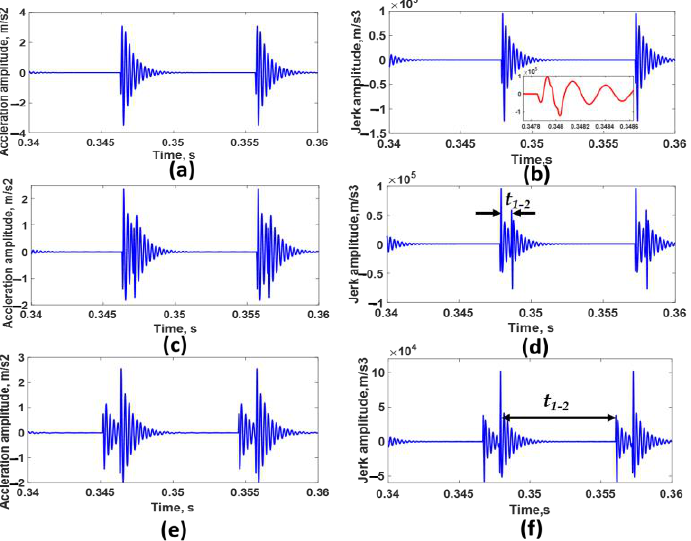
Figure 9. Dynamic response (acceleration and jerk) of a bearing has a bump and dent on its outer race with different angles between them: ( a , b ) 0.415° (radial distance d), ( c , d ) 3.139° (radial distance 8 d), and ( e , f ) 34.8° (radial distance 84 d).